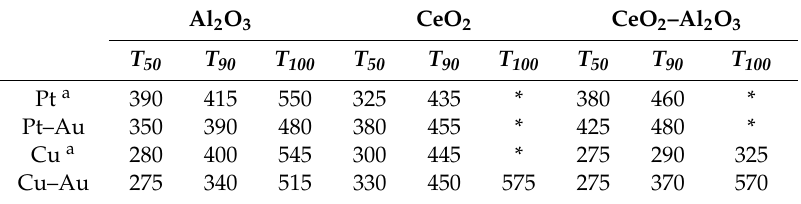
Table 5. Summary of the T 50 , T 90 , and T 100 temperatures of tested catalysts (°C, rounded to 5 °C).